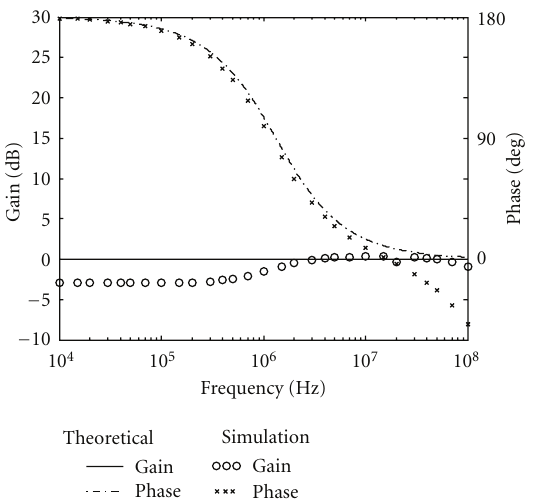
Figure 7: Simulation results of the proposed current-mode first- order lowpass filter.